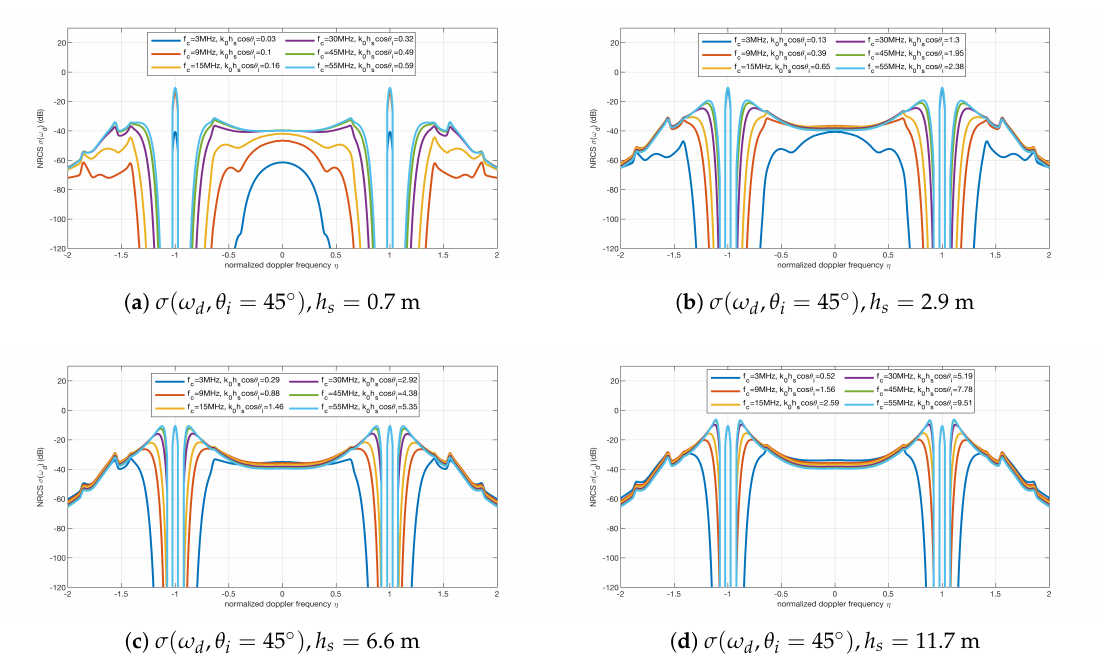
Figure 4. The Doppler spectra for θ i = 45 ◦ with different f c and h s . ( a ) σ ( ω d , θ i = 45 ◦ ) , h s = 0.7 m; ( b ) σ ( ω d , θ i = 45 ◦ ) , h s = 2.9 m; ( c ) σ ( ω d , θ i = 45 ◦ ) , h s = 6.6 m; and ( d ) σ ( ω d , θ i = 45 ◦ ) , h s = 11.7 m. For each pair of θ i and h s , six radar frequencies were selected to simulate the spectra. The six values of f c were 3, 9, 15, 30, 45 and 55 MHz. The dominant wave direction α (cid:48) is 90 ◦